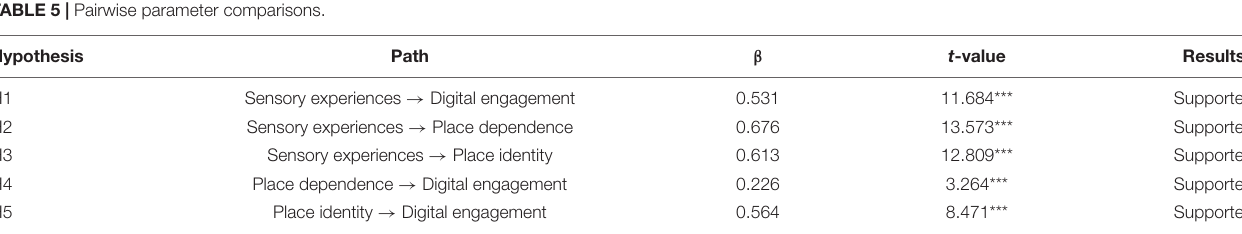
TABLE 5 | Pairwise parameter